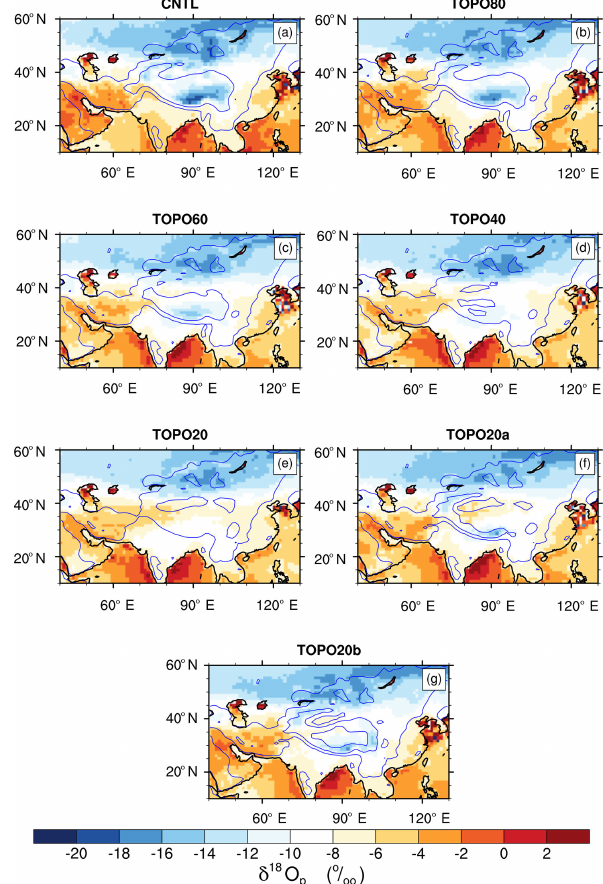
Figure 3. Mean-annual precipitation-weighted ECHAM δ 18 O p (in ‰) for the (a) CNTL, (b) TOPO80, (c) TOPO60, (d) TOPO40, (e) TOPO20, (f) TOPO20a, and (g) TOPO20b cases. The blue con- tour lines represent 500 and 2000m surface elevation